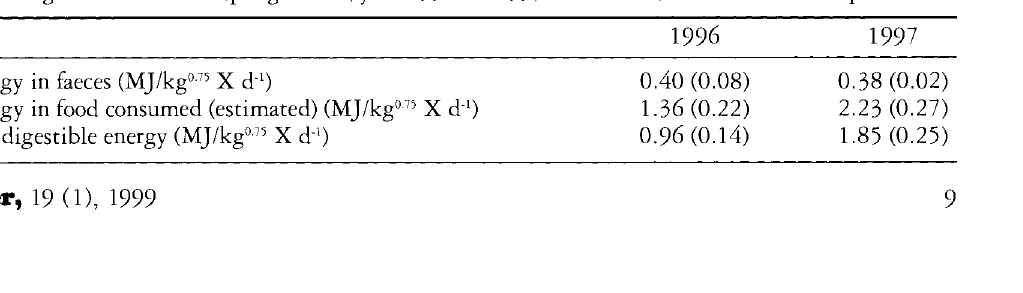
Table 5. Total energy in faeces and apparent digestible energy in food eaten (estimated) by male reindeer yearlings grazing on old meadow in spring at Reinøya in 1996 and 1997. Mean with standard deviation in